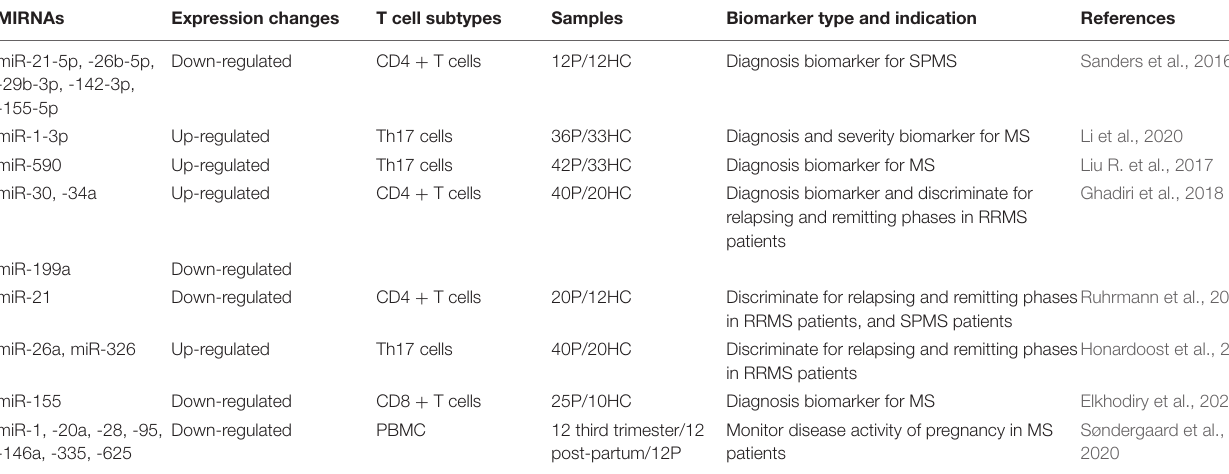
TABLE 2 | Studies of diagnostic or prognostic biomarkers in patients of multiple sclerosis.